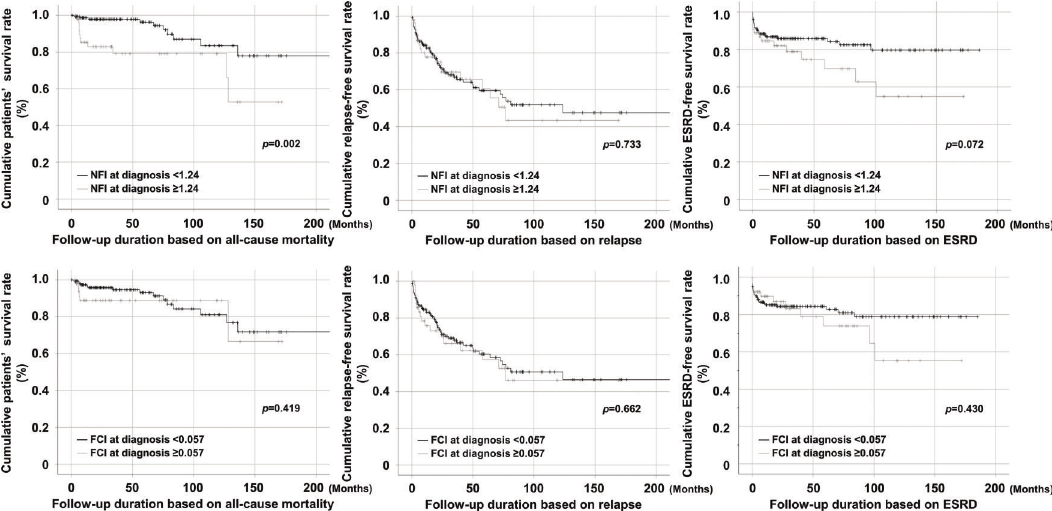
Figure 2 - Comparison of the cumulative survival rates. Among six conditions, it was found that only AAV patients with NFI at diagnosis X 1.24 exhibited a significantly lower cumulative patients ’ survival rate than those without. NFI: novel fibrosis index; ESRD: end-stage renal disease; FCI: fibrosis cirrhosis index. Table 3 - Cox hazards model analysis of variables at diagnosis for all-cause mortality during follow-up in AAV patients. Univariable Multivariable Variables HR